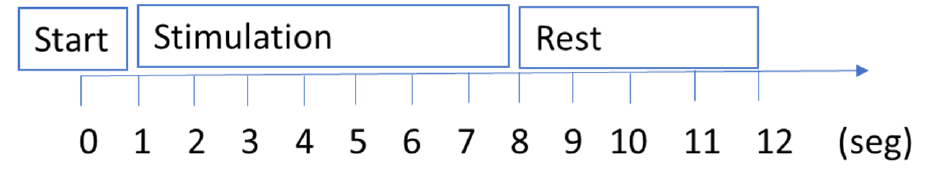
Figure 3. Timing of a single SSVEP trial.